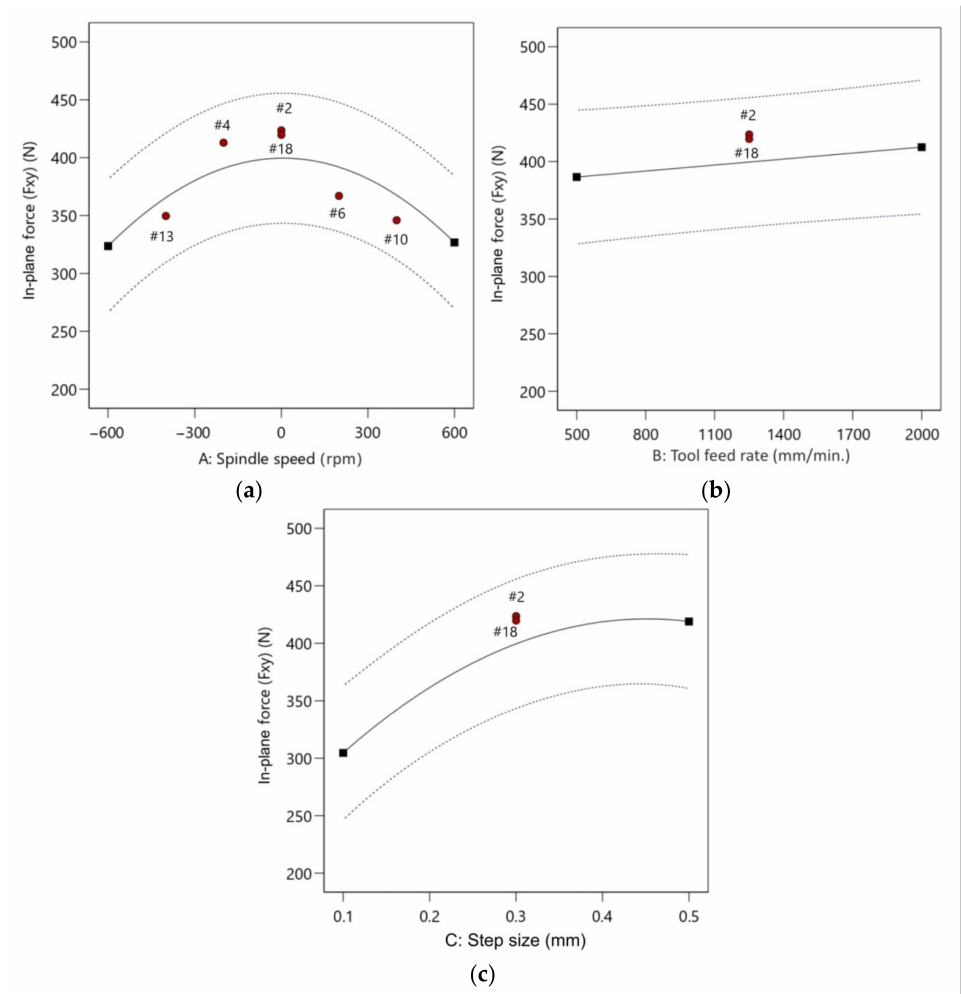
Figure 12. Plots showing the effect of: ( a ) spindle speed; ( b ) feed rate; and ( c ) step size on in-plane force. Table 7. ANOVA results of the surface roughness parameter Rz in